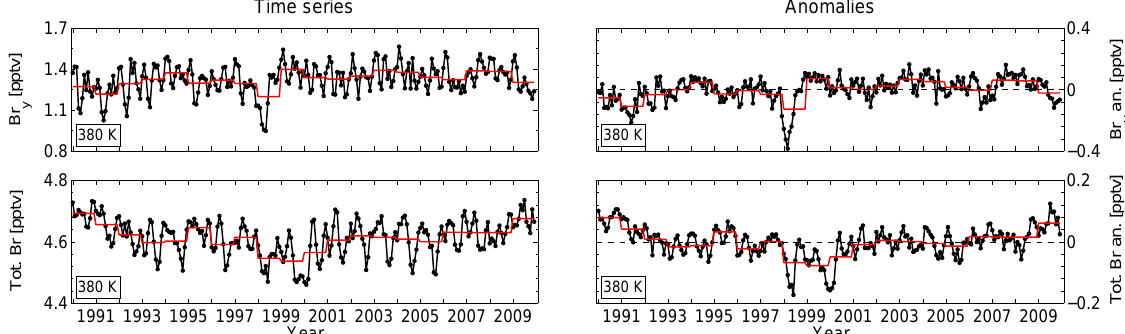
Fig. 11. Timeseries of Br y , total bromine and the corresponding anomalies as in Fig. 10 but from the sensitivity run without heterogeneous